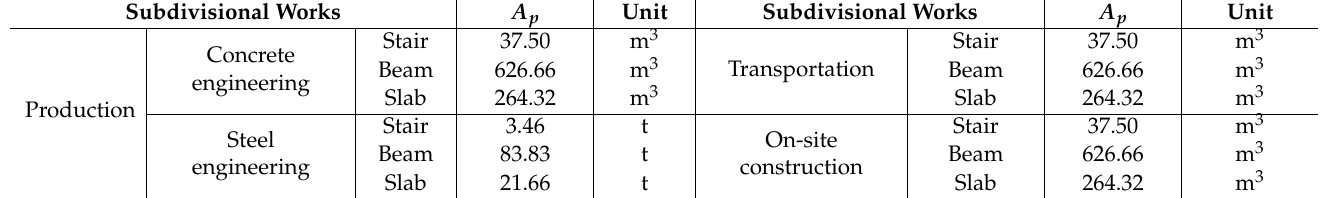
Table 6. Real Engineering Quantities of Subdivisional Works (Prefabrication).